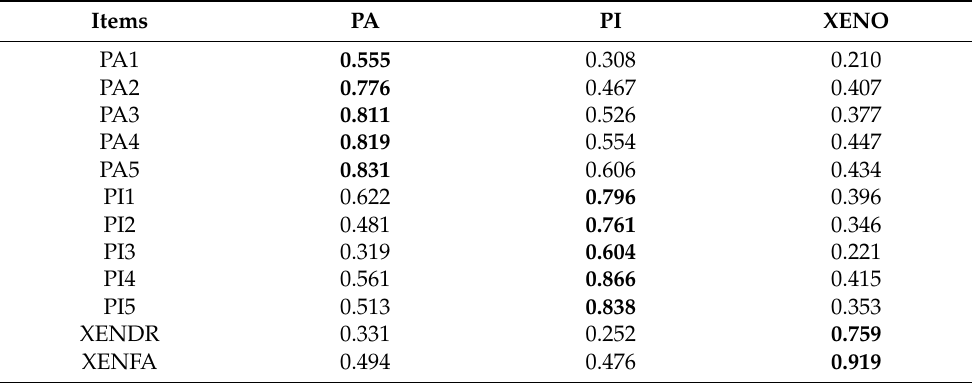
Table 3. Cross-loadings of higher-order model.